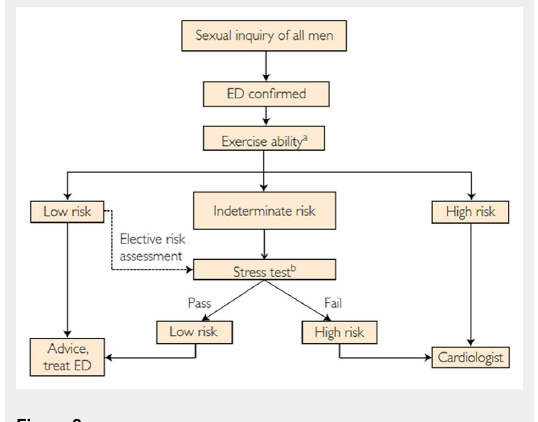
Management of erectile dysfunction (ED) in patients with cardiovascular disease.